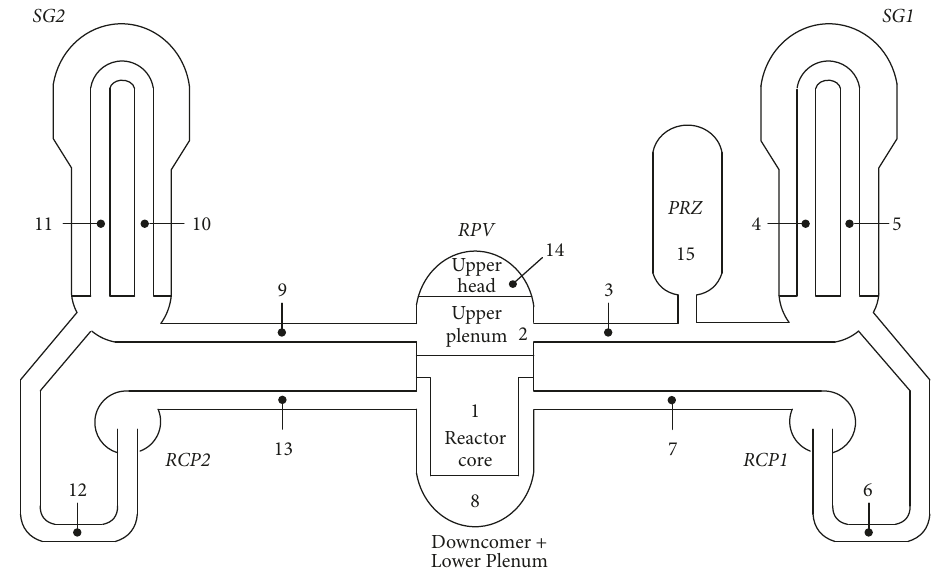
Figure 3: MAAP nodalization of the primary system, taken from [7].